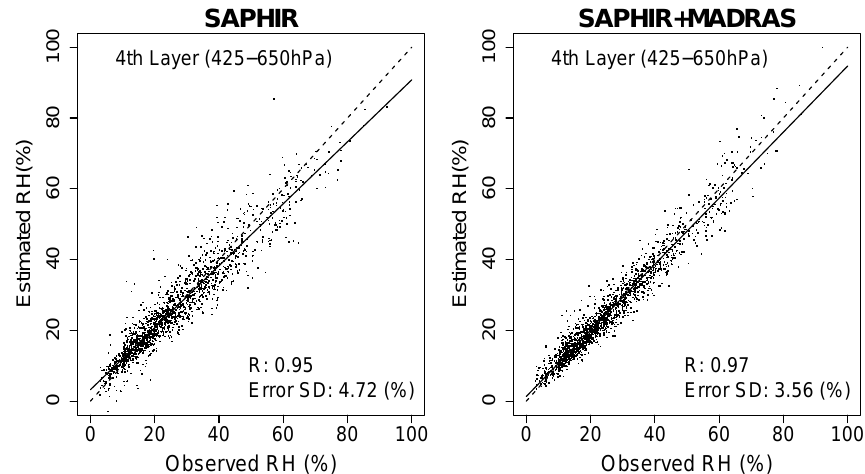
Figure 6. Scatter-plots of the observed RH versus the estimated RH (in %RH) for layer 4 (top row) and layer 6 (bottom row). The estimations are done using GAMs trained from SAPHIR-only BTs (left-hand side column) and from SAPHIR and MADRAS BTs (right-hand side column). The dashed line is y = x line and the solid line represents the linear regression. The correlation coefficient ( R ) and the standard deviation of the error (SD) are provided within each